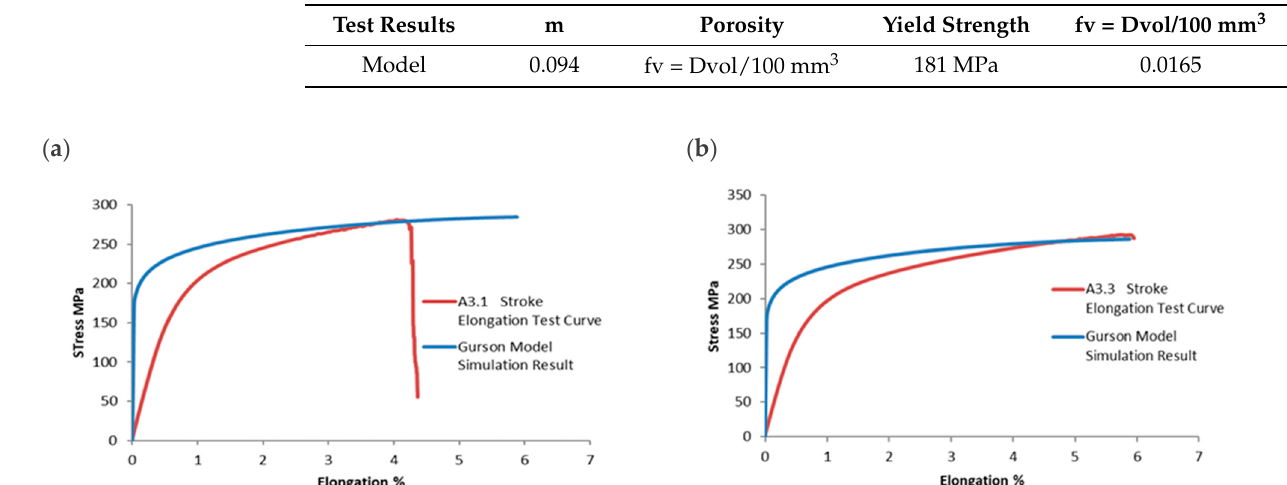
Table 8. Tomography Defect Metrics A3.1 Alloy Set and Porosity Calculation.